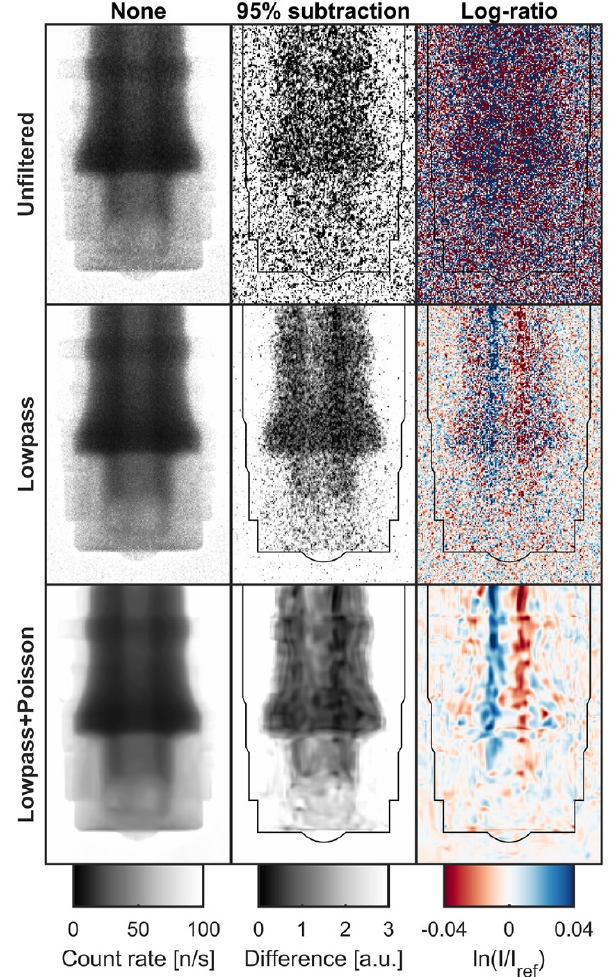
Figure 6. Filtering and normalization methods for high-speed imaging. Image is from a time bin with a relatively large needle deflection ( t = 2.27 ms). Rows correspond to filtering, and columns correspond to normalization. The injector body outline has been overlaid on the normalized images for clarity. Variations in neutron count rate due to displacement of the injector needle are apparent in the normalized images due to the difference in attenuation coefficient between the steel needle and the surrounding hydrogenous fuel, with movement of the needle toward light and away from dark in the subtraction images, and toward blue and away from red in the log-ratio images.